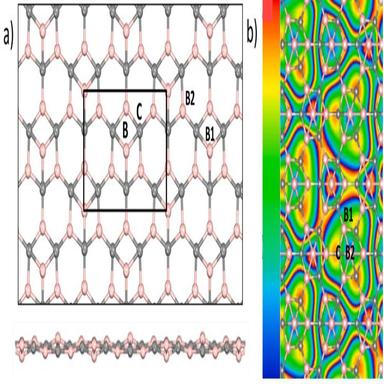
a) The top and side views of B4C3 monolayer. b) Electron localization function 0 and 1 represents blue and red colors. (For interpretation of the references to colour in this figure legend, the reader is referred to the web version of this article.)